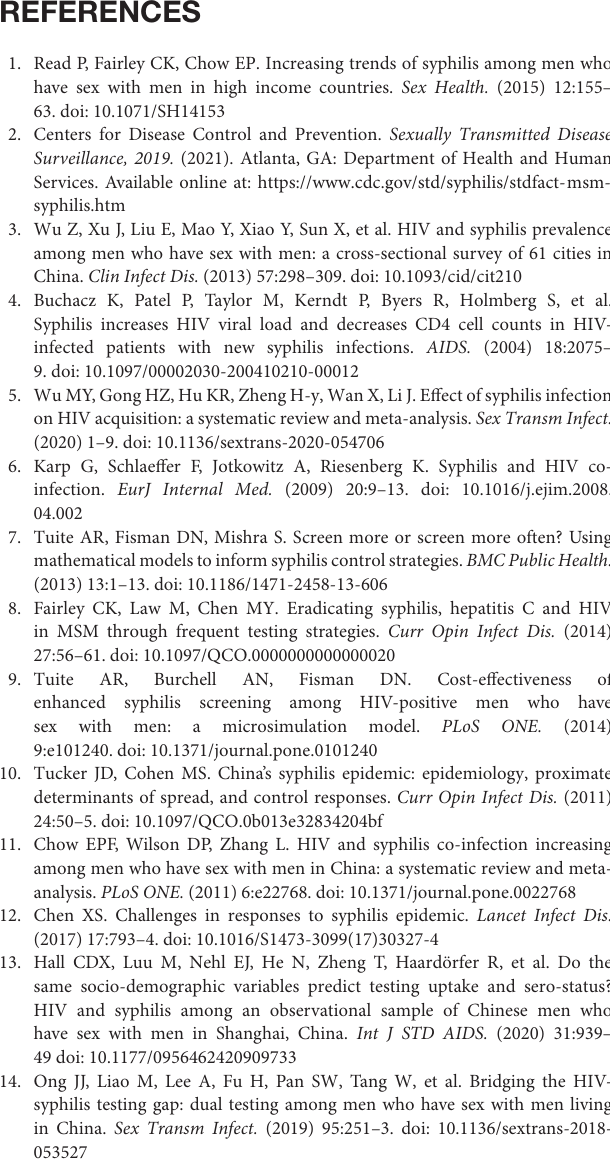
ratios (black squares) and their 95% confidential intervals (Cis, horizontal lines), as well as P -values for the interaction between ART initiation and the subgroup variables. A P -value < 0.05 is statistically significant. ∗ P < 0.05; ∗∗ P < 0.01; ∗∗∗ P < 0.001. MSM, men who have sex with men; STI, sexually transmitted infection; HIV, human immunodeficiency virus; AIDS, acquired immune deficiency syndrome. Supplementary Table 4 | Differences between ART-treated MSM with or without CD4 + T Cell recovery during 2008 and 2012 in Guangzhou,